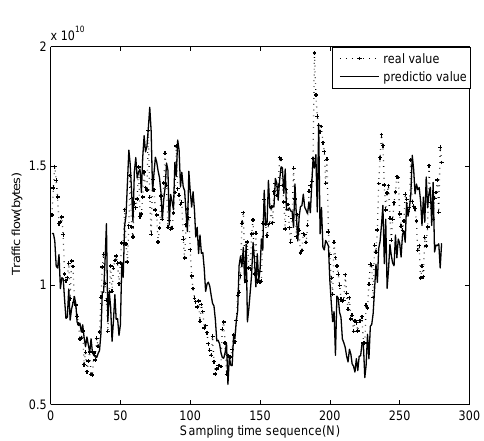
Figure 3. Comparison between the real and prediction traffic in two-steps prediction